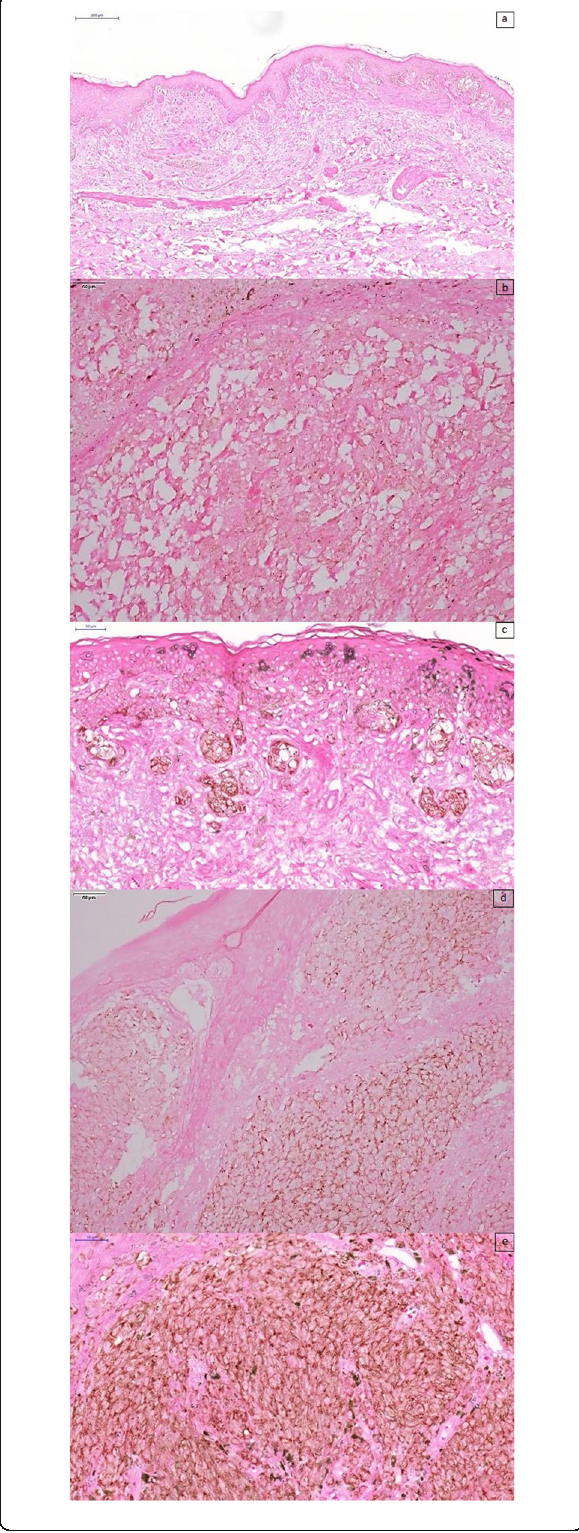
Fig. 1 Positivity to IMP3 immunostaining contra-colored by Giemsa, 400× Footnote: Score: zero ( a ), 1+ ( b ), 2+ ( c ), 3+ ( d ) and 4+ ( e ). The positivity rate took into account the positivity in the total tumor area. Note that melanin appears as coarse black